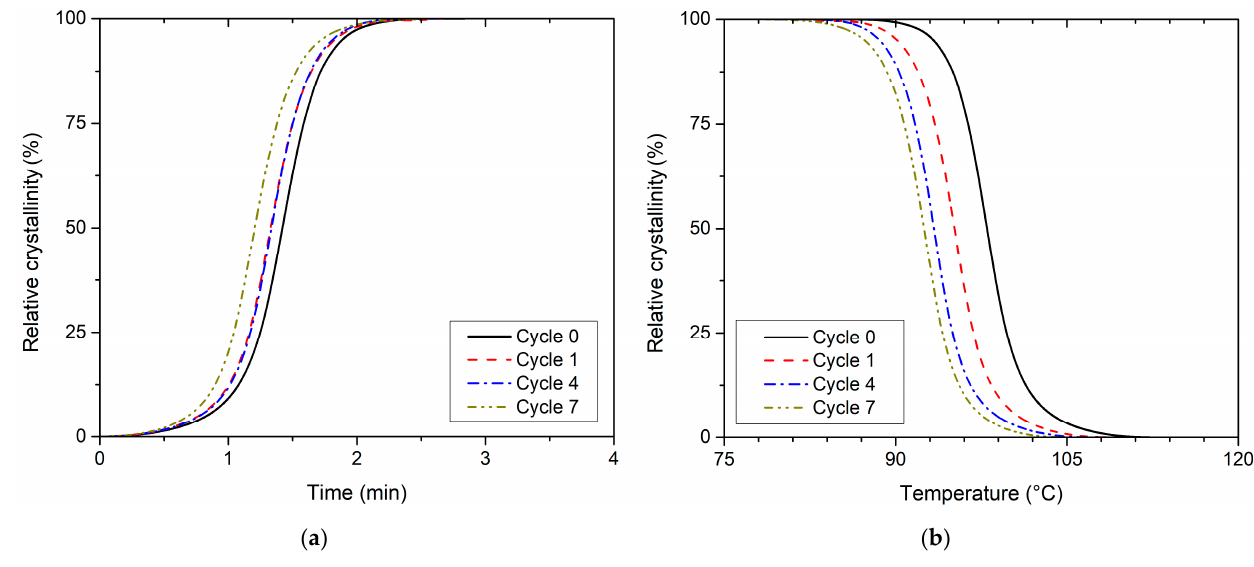
Figure 8. Relative crystallinity versus ( a ) time and ( b ) temperature for non-isothermal cold crystallisation PLLA.